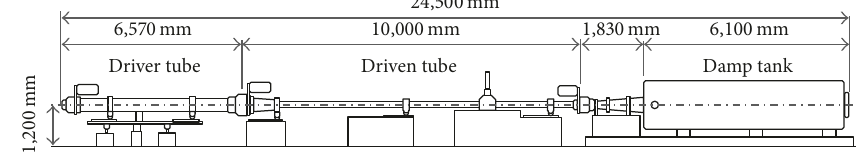
Figure 2: Dimensions of the shock tunnel of Nagoya University.